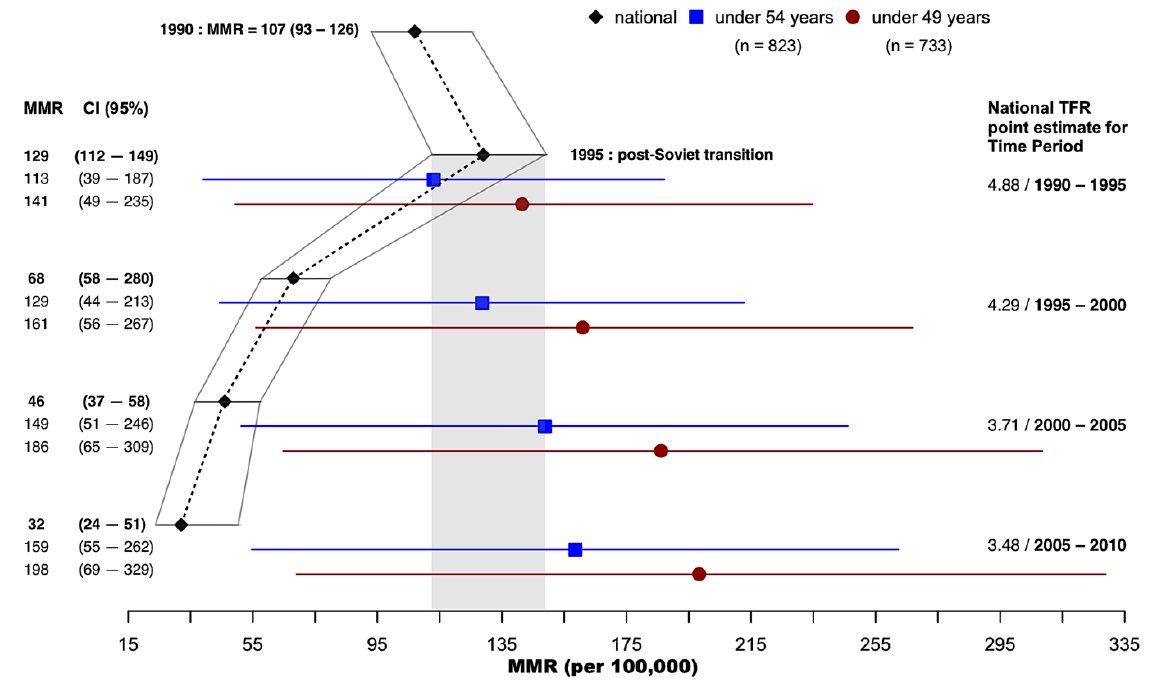
Figure 1. GBAO Tajikistan Sisterhood estimated MMR (per 100,000) with 95% confidence intervals MMR estimates using the national TFR (4.88) for the same period based on time-lag (1990-1995) are congruent with the spike shown for national levels in 1995. MMR estimates using dropping TFR values during the post-Soviet fertility transition illustrate the stability or potential increase in MMR in this region compared to the national estimates for the same time period if urban improvements in maternal mortality outpace